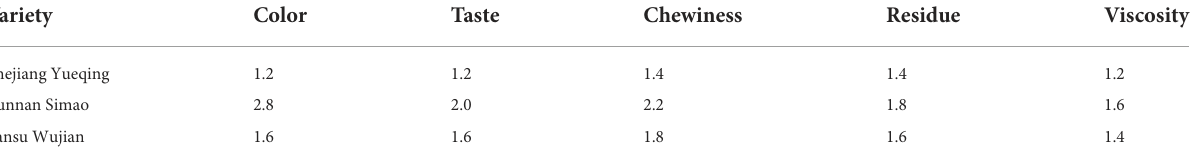
TABLE 7 Fresh edible stems sensory evaluation of different Dendrobium candidum strains.